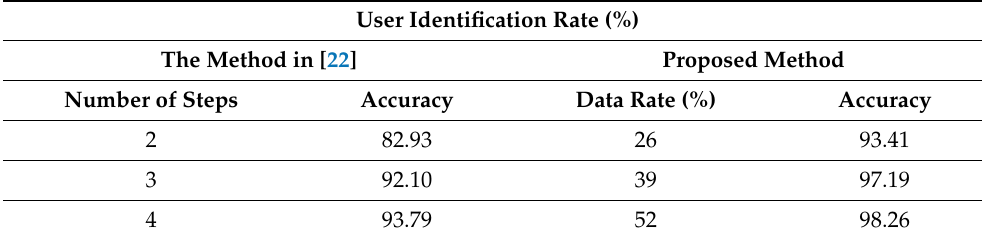
Table 2. Recognition results of the proposed method and the method in